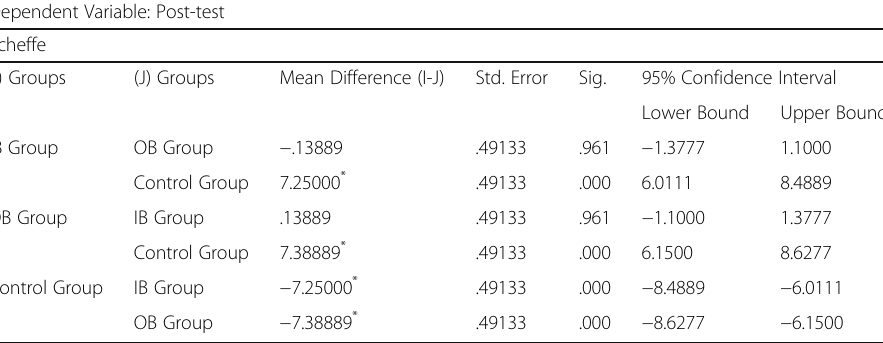
Table 6 Post-hoc Test, Multiple Comparisons (Post-tests Dependent Variable: Post-test